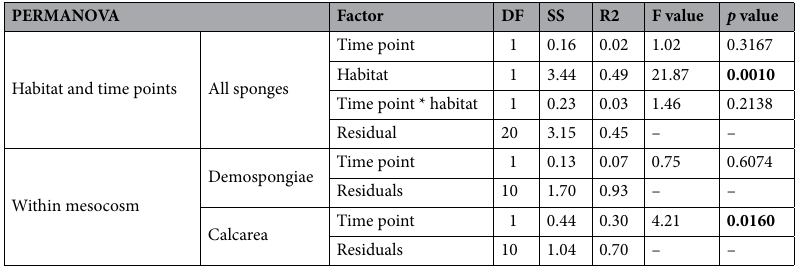
Table 3. Permutational analysis of variance (PERMANOVA) based on Bray–Curtis distances between mesocosm and reef ARMS on time points showing peak and minimum sponge recruitment. Analysis was also performed on the most dominant sponge classes within mesocosm ARMS. Significance is based on p < 0.05. Significant values are in bold.